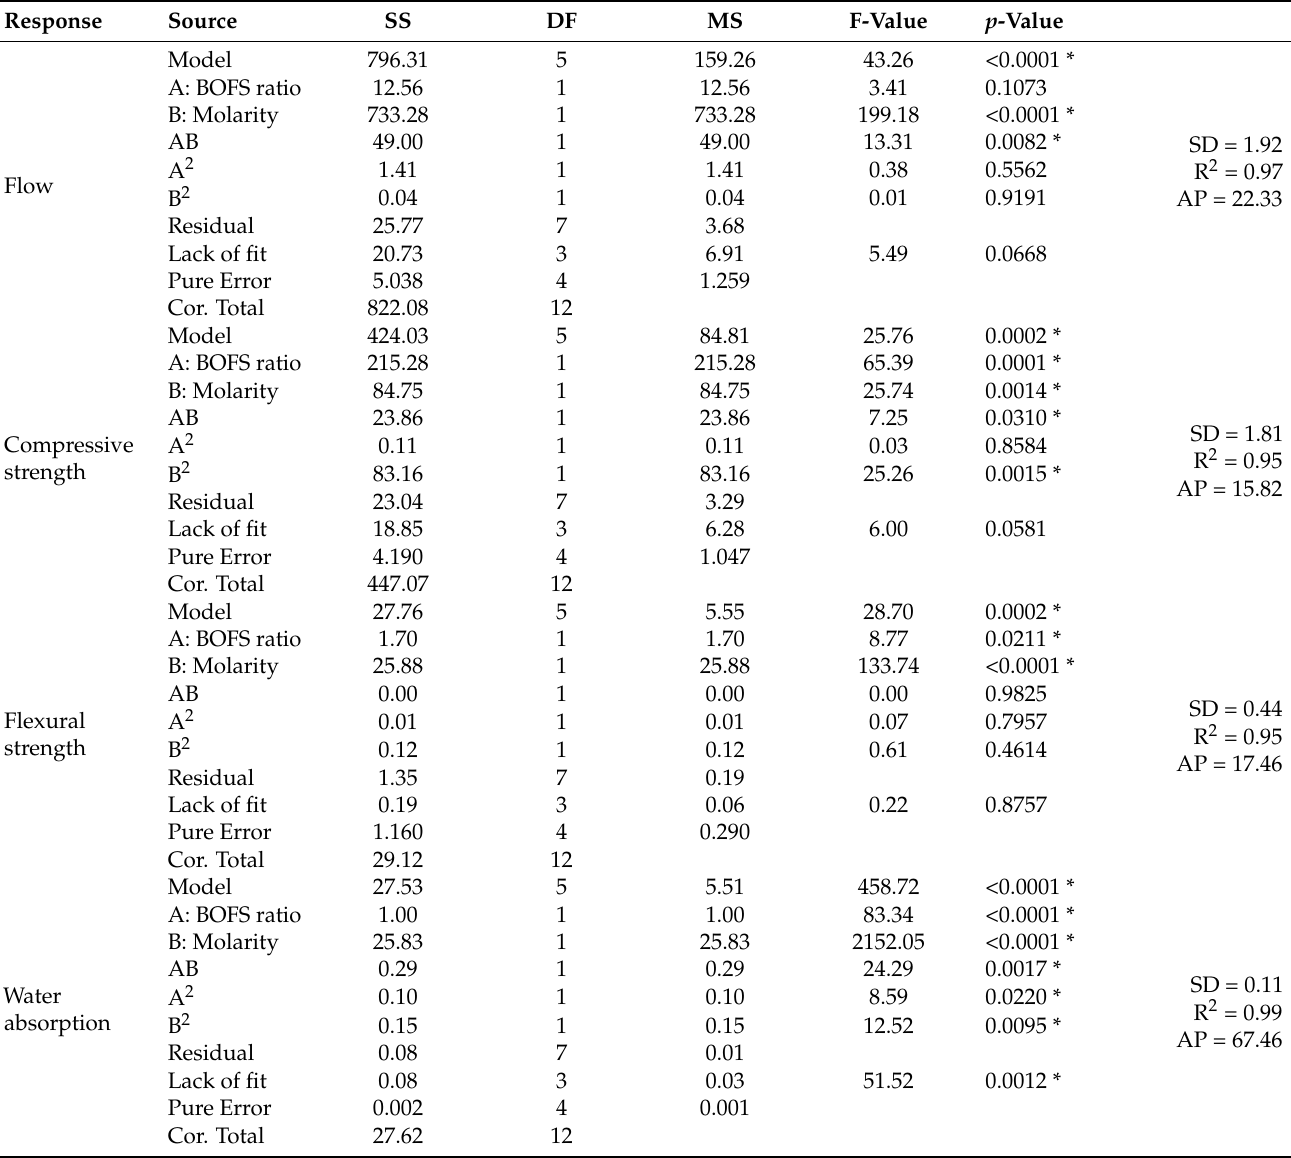
Table 4. ANOVA results of the analyzed